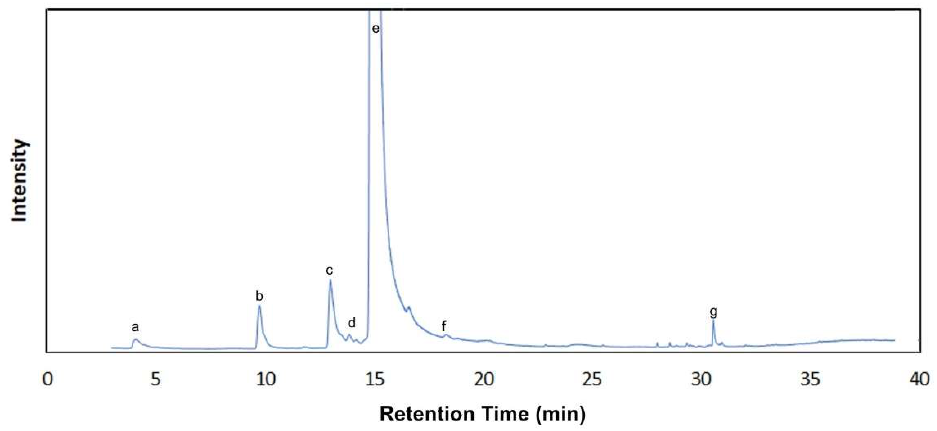
Figure 1. Representative chromatogram of pasteurized orange juice: (a) ethyl butanoate, (b) α -pinene, (c) 3-carene, (d) terpinolene, (e) limonene, (f) γ -terpinene, and (g) eremophila-1(10),11-diene.